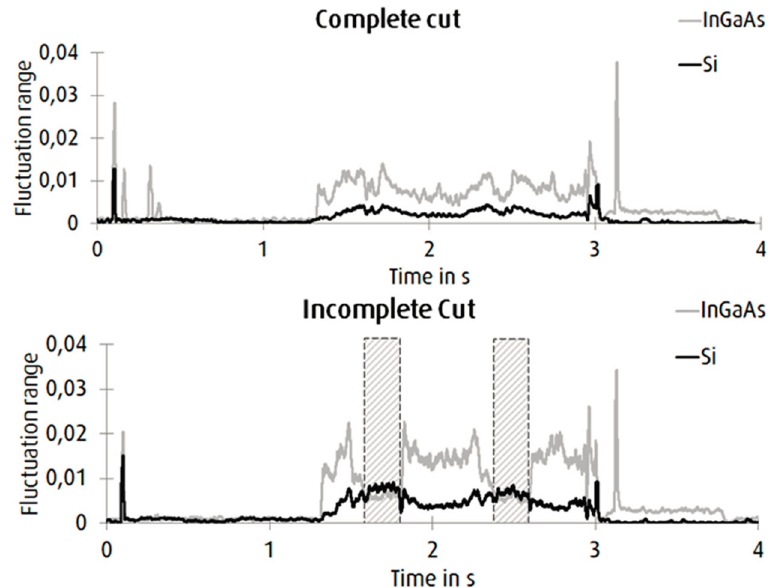
Figure 6. Fluctuation range of the high pass filtered signal for a complete cut ( top ) and incomplete cut ( bottom ). The time domain with cutting interruption is marked by dashed lines.